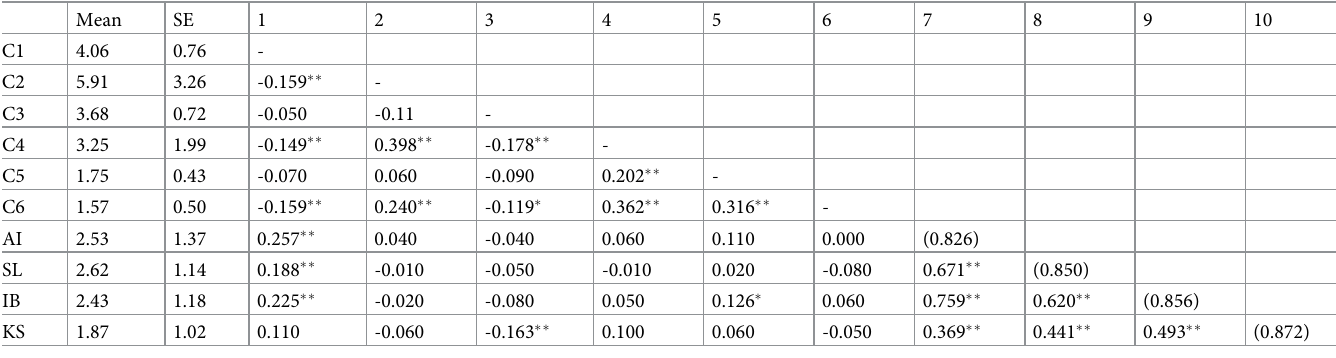
Table 5 presents the mean, standard deviation, correlation coefficient, and square root of each variable’s AVE value. AI was positively correlated with IB ( β = 0.759, p < 0.05), SL ( β = 0.671, p < 0.05), KS ( β = 0.369, p < 0.05), and KS ( β = 0.493, p < 0.05). Therefore, hypotheses H1, H2, and H3 were preliminarily verified.